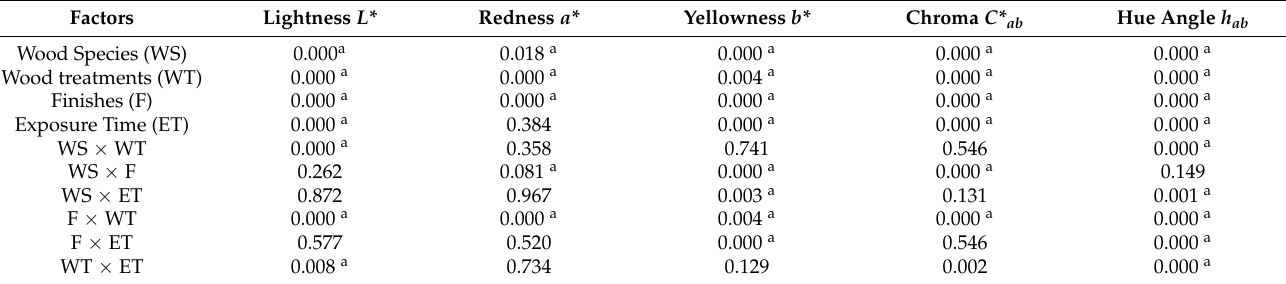
Table 2. Results of statistical evaluations of the colour